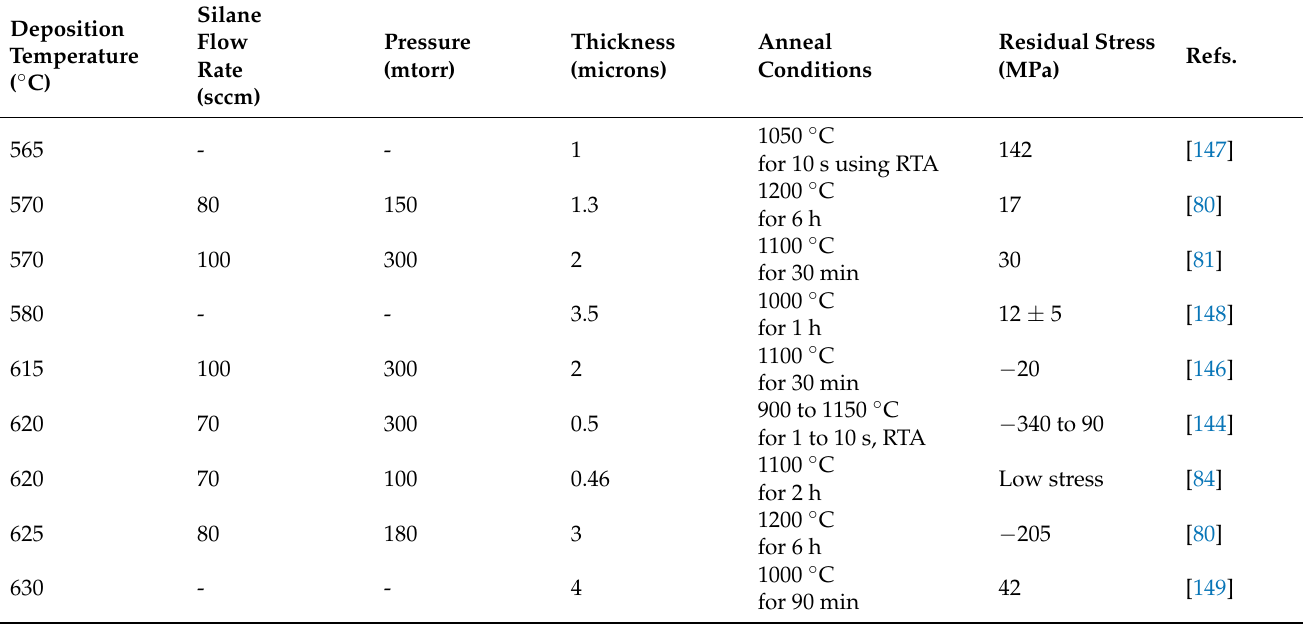
Table 20. Residual Stress in Undoped LPCVD Polysilicon Thin-Film Material Layers After High- Temperature Annealing.